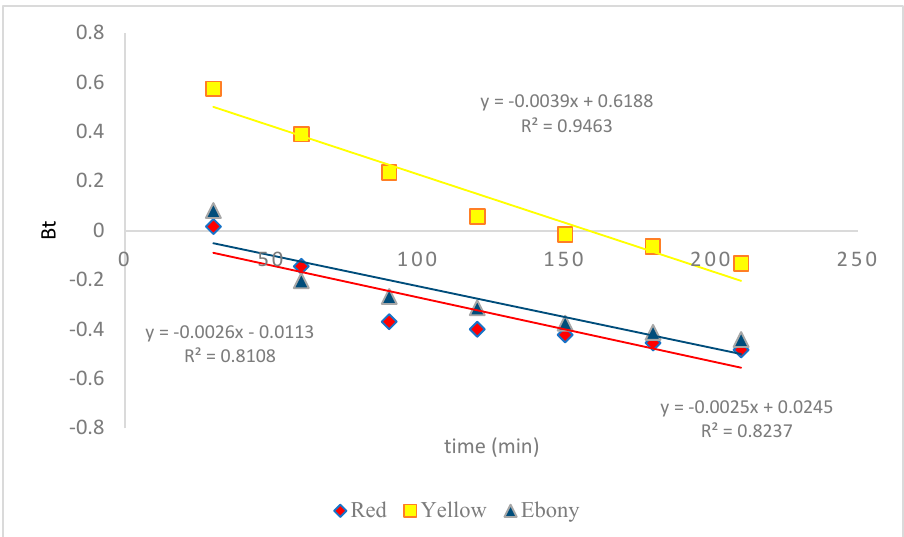
Figure 12. Boyd Plot for R, Y, and E hair dyes uptake onto COZ adsorbent .